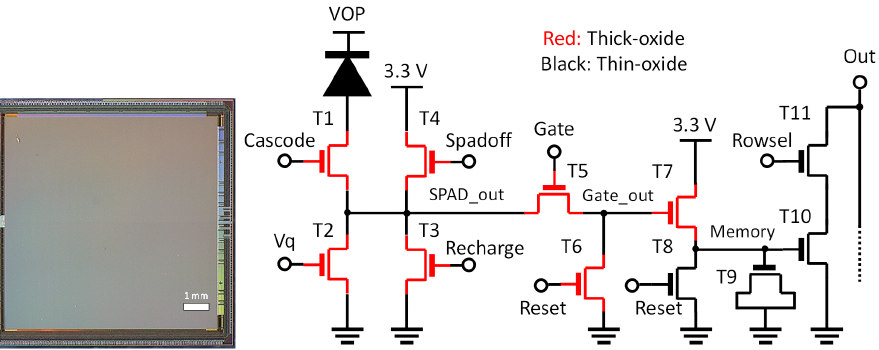
Figure 4. SwissSPAD2 photomicrograph ( left ) and pixel schematics ( right ). The pixel consists of 11 NMOS transistors, 7 with thick-oxide, and 4 with thin-oxide gate. The pixel stores a binary photon count in its memory capacitor. The in-pixel gate defines the time window, with respect to a 20 MHz external trigger signal, in which the pixel is sensitive to photons. The image is reproduced with permission from Ref. [22], copyright IEEE,